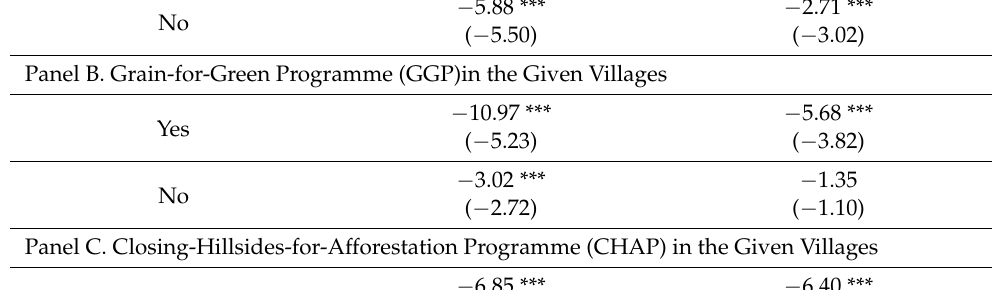
2SLS (Y = Arable Land Abandonment) (1) (2) 1.37 4.10 (0.08) (0.15) − 5.88 *** ( − 5.50) ( − 3.02) − 10.97 *** ( − 5.23) ( − 3.82) − 3.02 *** − 1.35 ( − 2.72) ( − 1.10) − 6.85 *** ( − 2.92) ( − 3.13) − 3.86 *** ( − 0.97) − 7.86 * 0.20 ( − 0.85)